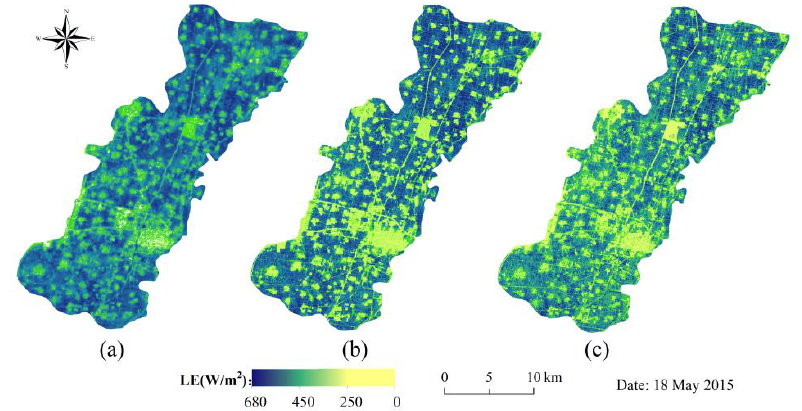
Figure 7. Spatial distribution of instantaneous winter wheat LE derived from Landsat 8 on 18 May 2015 for the (Equation) TSEB, (Equation) 4s-PM, and (Equation) PT-JPL models.